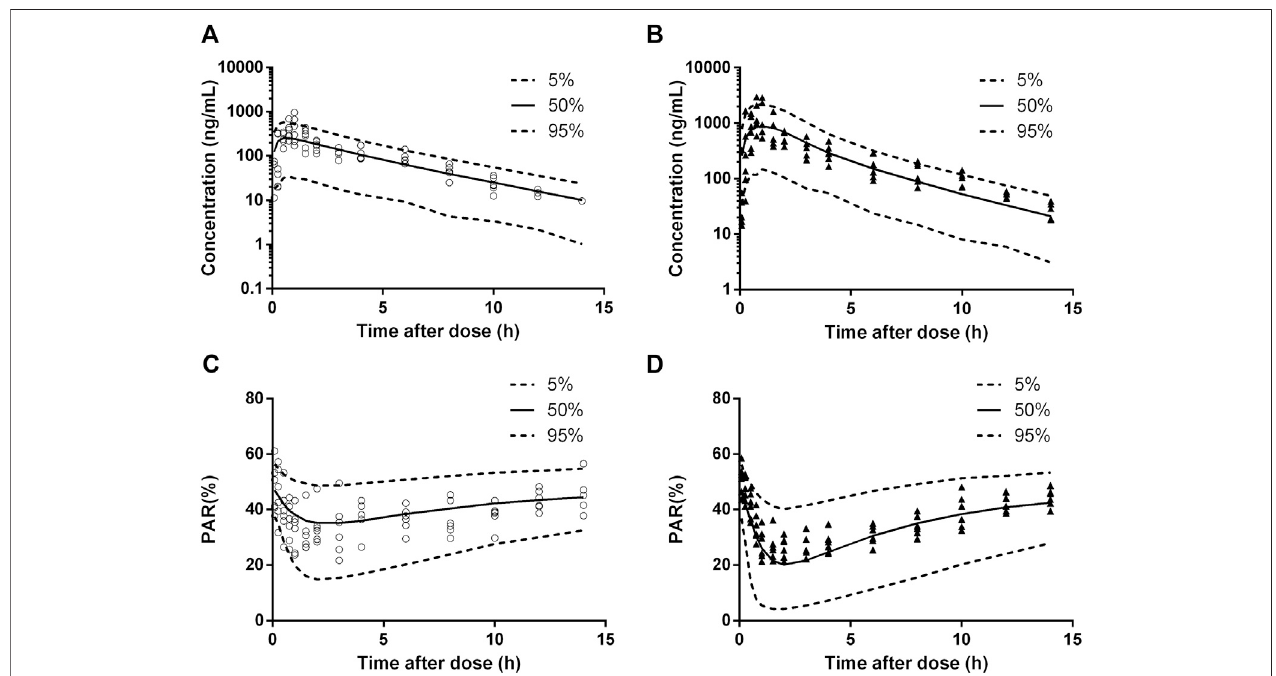
FIGURE5| Visualpredictioncheckforpharmacokinetic(PK)andpharmacodynamic(PD)estimationafterasingleoraldoseof2.5 mg/kg(cicles,n (cid:2) 6)andthe fi rst administration of multiple doses of 5 mg/kg (triangles, n (cid:2) 6). (A), 2.5 mg/kg dosing for PK. (B), 5 mg/kg dosing for PK. (C), 2.5 mg/kg dosing for PD. (D), 5 mg/kg dosing for PD. Solid and dashed lines depict median and 90% CI of model predictions.